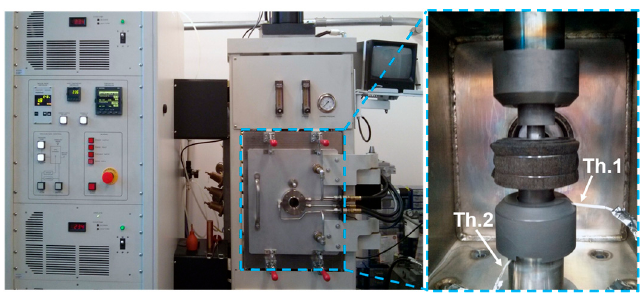
Figure 9. The SPS device Thermal Technology 10-4 with marked positions of thermocouples (Th.) for precise temperature control.